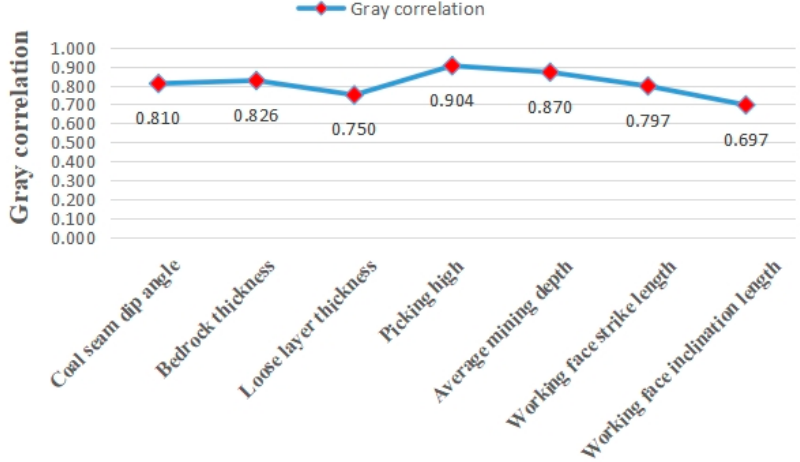
Figure 7. Gray correlation between the influencing factors of surface subsidence and surface subsidence coefficient in Lu’an mining area.